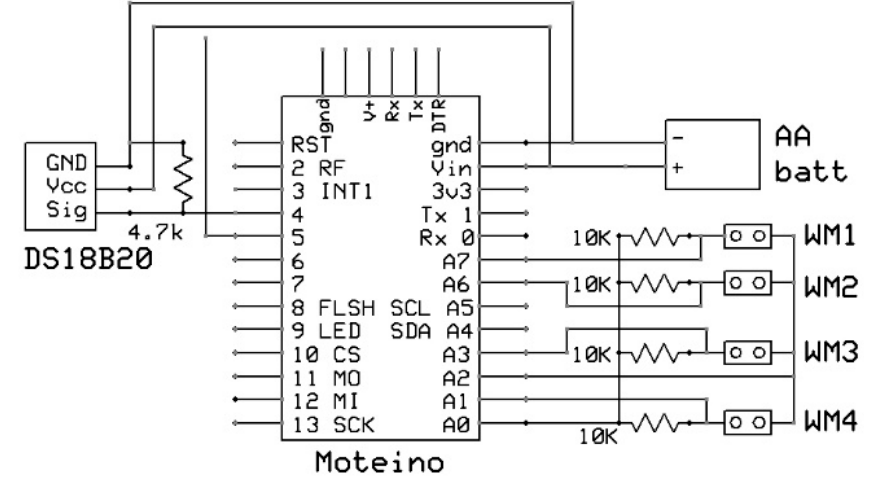
Figure 2. Sensor node electrical schematic.